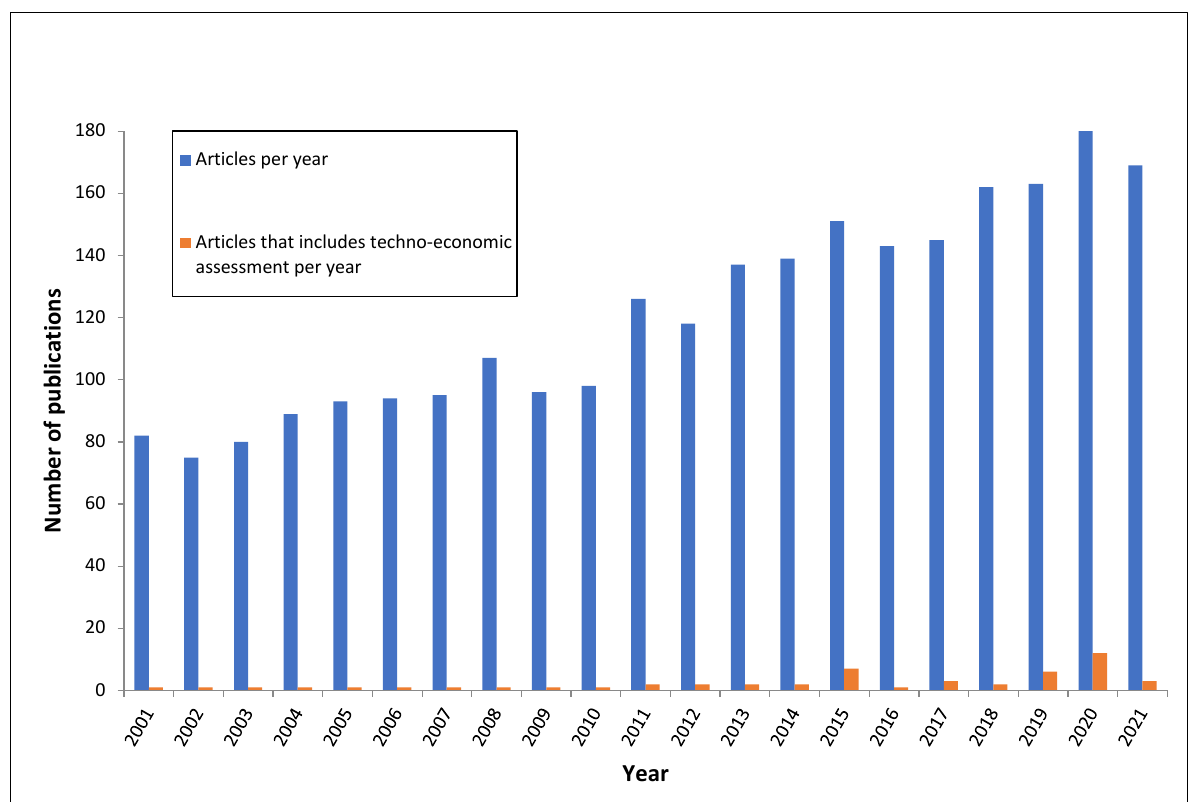
Figure 1. Evolution of scientific literature related to enzymatic ester syntheses published between 2001–2021 (blue bars) and the number of studies dedicated to the economic assessment of enzymatic ester syntheses (orange bars). Data were obtained in a survey on Web of Science database. Blue bars search strategy: ((TI = ((ester* OR “alkyl ester*” OR “flavor ester*” OR esterification) AND (lipase* OR “immobilized lipase*” OR biocataly*) AND (synthes*))) OR AB = ((ester* OR “alkyl ester*” OR “flavor ester*” OR esterification) AND (lipase* OR “immobilized lipase*” OR biocataly*) AND (synthes*))) AND DT = (Article). Orange bars search strategy: (TI = ((ester* OR “alkyl ester*” OR “flavor ester*” OR esterification) AND (lipase* OR “immobilized lipase*” OR biocataly*) AND (synthes*)) AND TS = (cost* OR econom* OR “economic assessment” OR “economic evaluation” OR “economic approach” OR “economic analysis” OR “operational costs” OR “Pilot-plant scale” OR pilot* OR feas*)) AND DT = (Article).